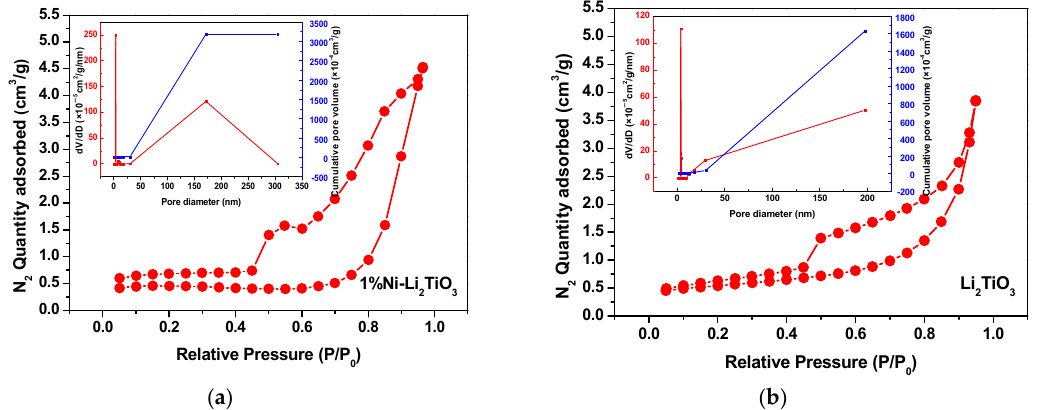
Figure 5. Nitrogen adsorption–desorption isotherm and pore size distribution for Li 2 TiO 3 . ( a ) Li 2 TiO 3 ; ( b ) 1% Ni-Li 2 TiO 3 .